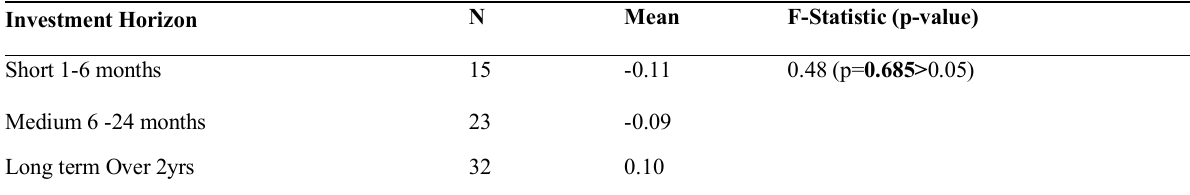
Table 3: ANOVA for shareholder loyalty based on investment horizon